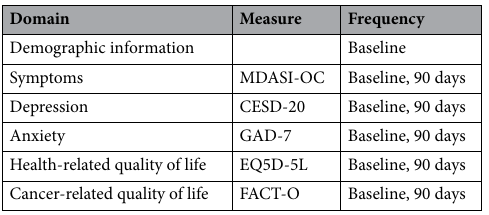
Table 1. Study domains, measures, and assessment